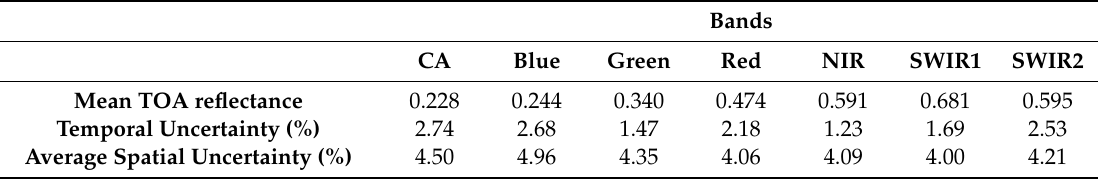
Table 5. Mean OLI (L8) TOA reflectance of Cluster 13 optimized path / rows by band, derived from 30 m image data. Bands CA Blue Green Red NIR SWIR1 SWIR2 Mean TOA reflectance 0.228